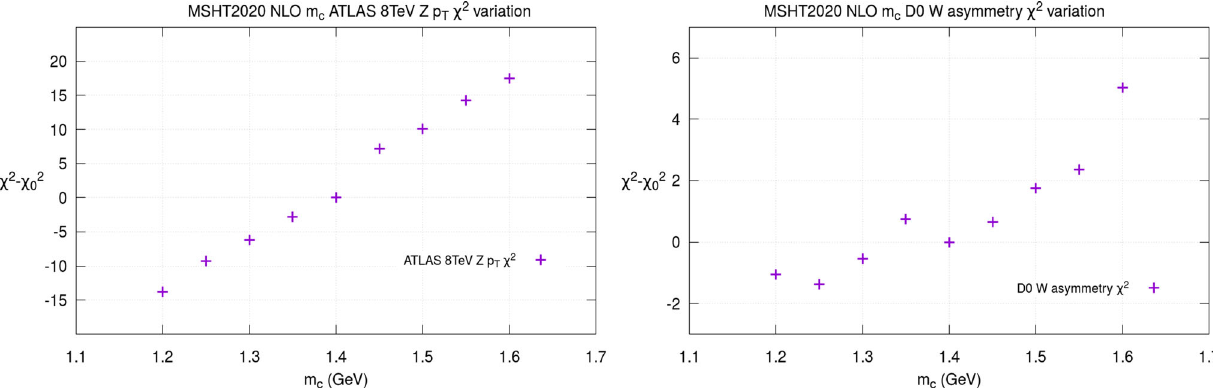
) = 0 . 118 for (left) the ATLAS 8 TeV Z p Z